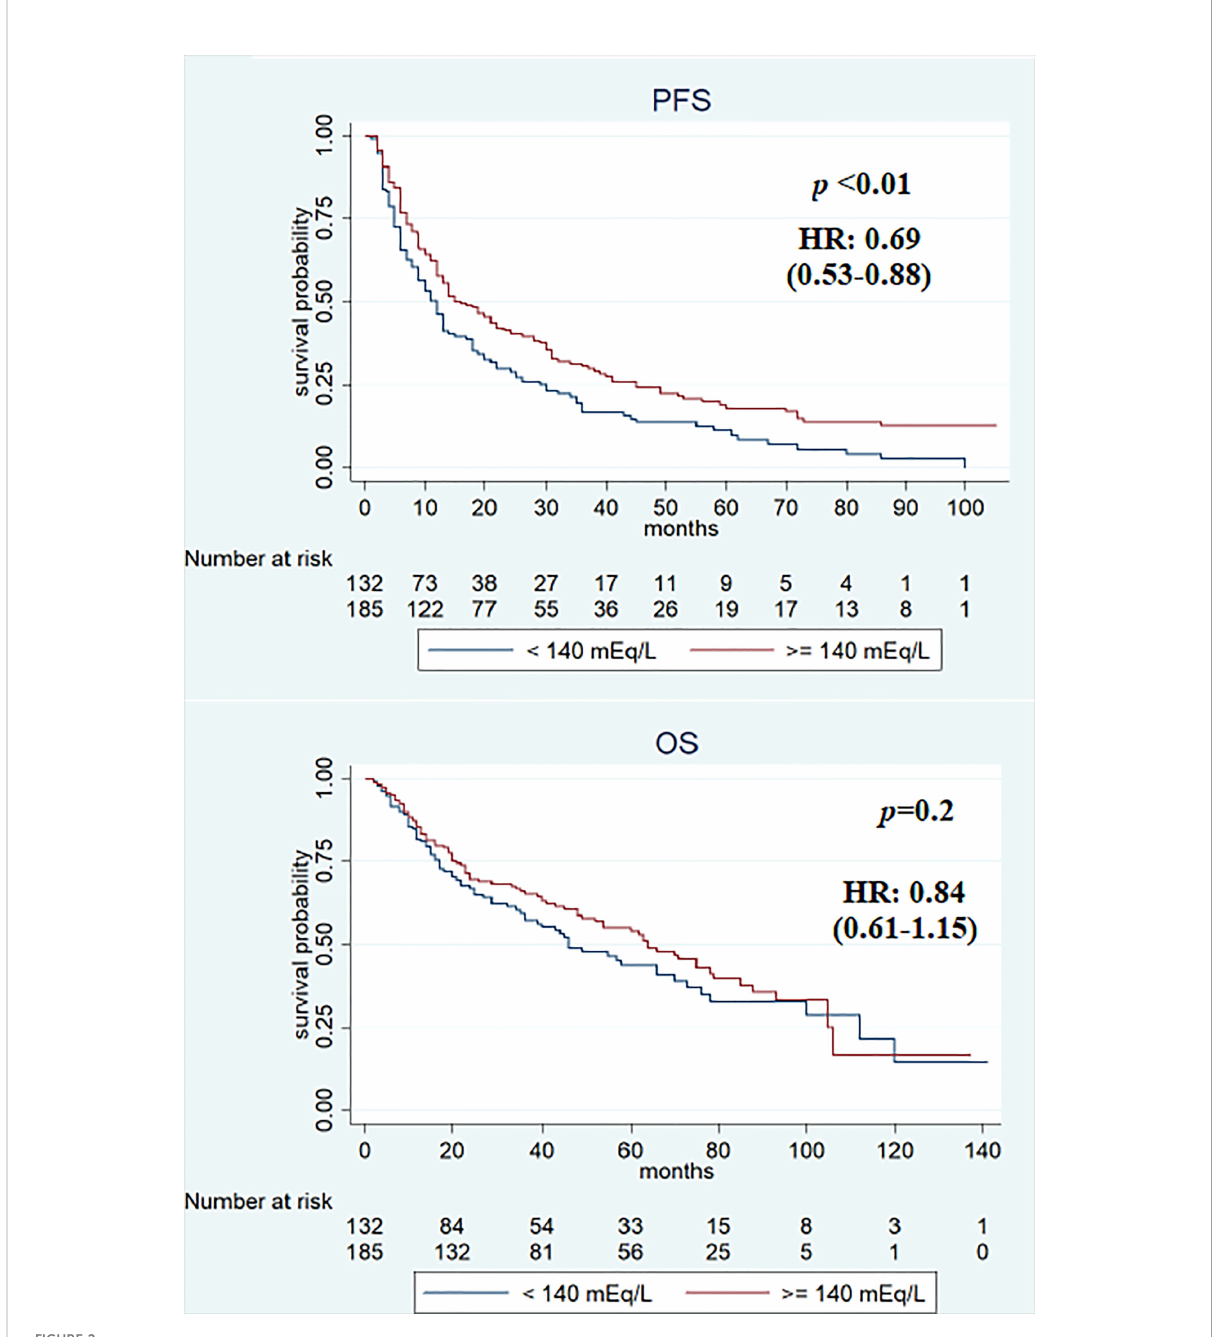
FIGURE 2 Kaplan – Meier survival estimate according to baseline sodium serum